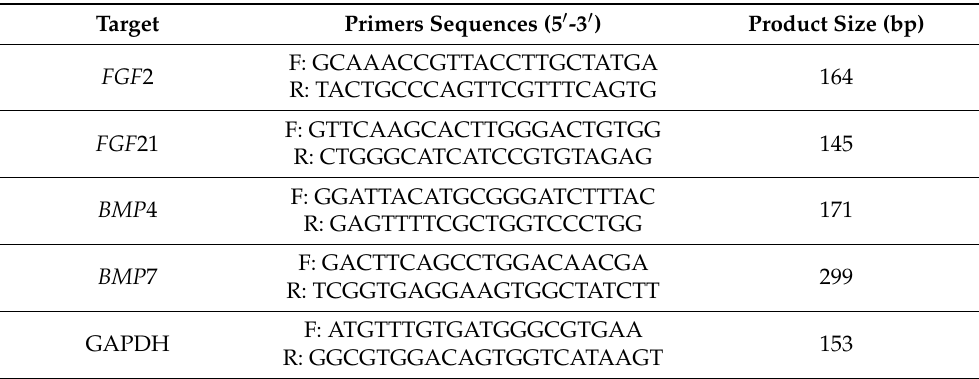
Table 2. Primers used for expression analysis in the